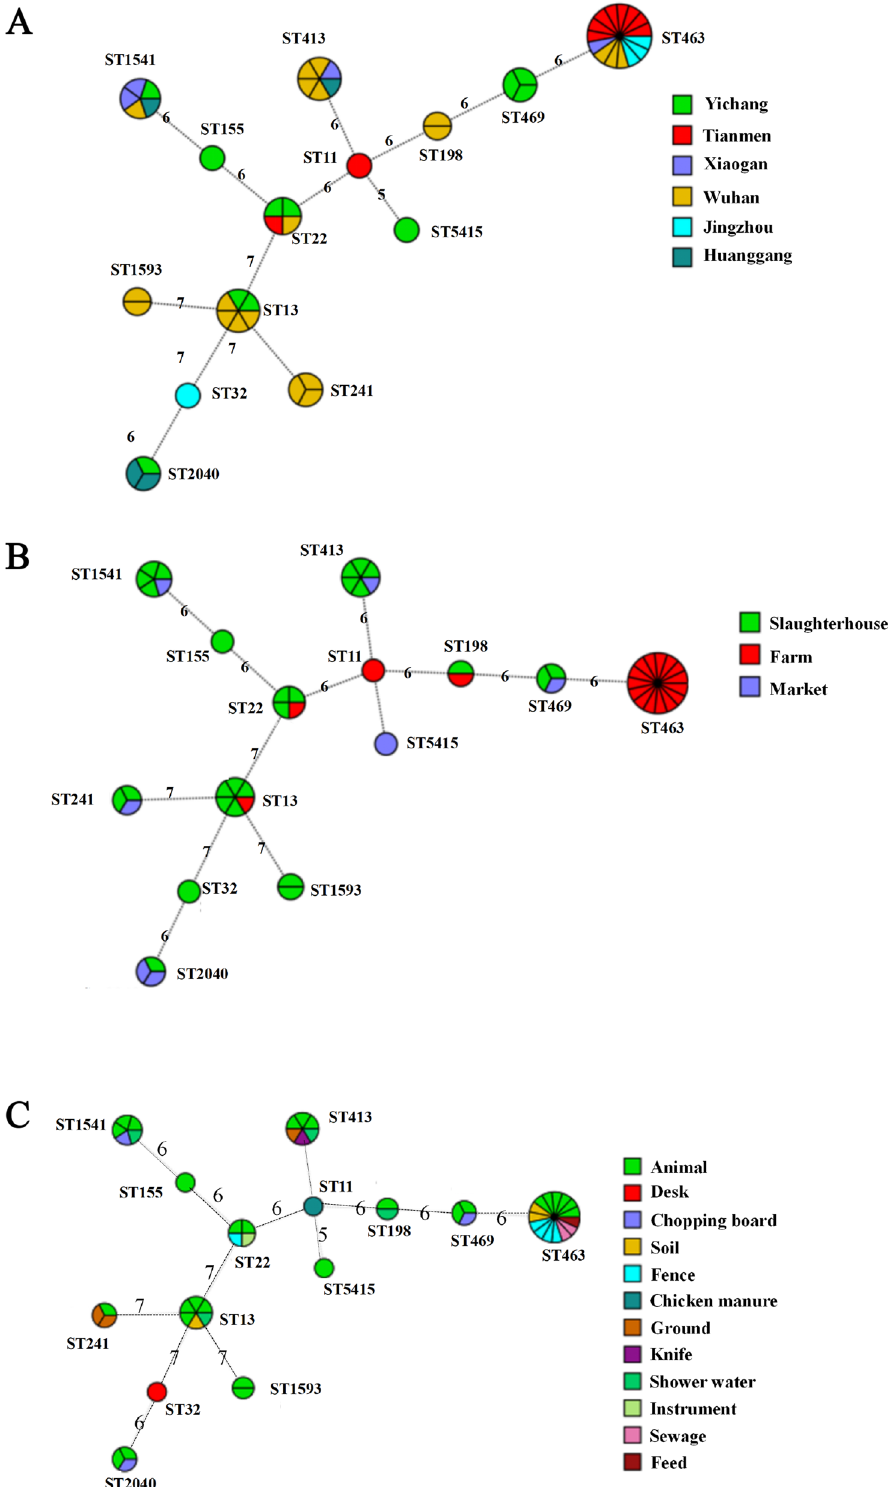
Fig. 6 MLST-based minimum spanning trees of 53 Salmonella strains classified by cities ( A ), links of the production chain ( B ) and animal or environmental sample sources ( C ). The number on the line represents the number of mutation sites of allele between the two ST